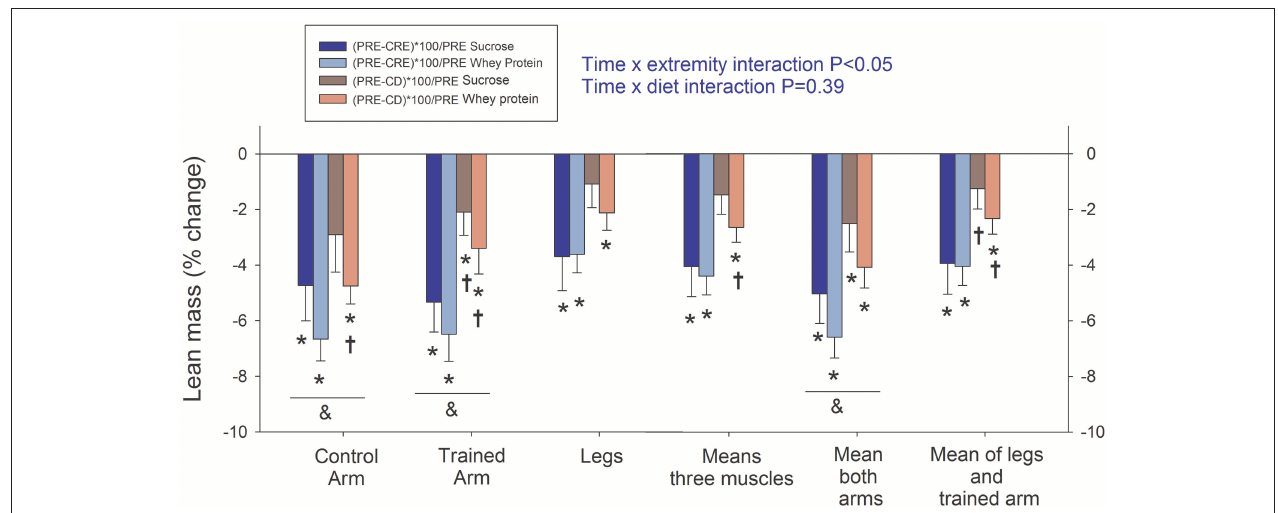
FIGURE 2 | Assessment of changes in lean mass (fat-free mass—bone mass) by dual-energy x-ray absorptiometry. PRE, baseline tests; CRE, caloric restriction (13.4 kJ/day) and exercise (45 min arm cranking and 8h walking per day) for 4 days; CD: 3 days on a diet isoenergetic with that consumed during the PRE phase + reduced exercise. The vertical bars represent the mean values and the error bars the standard error of the mean. Sucrose: in dark colors ( n = 7) and whey protein: in light colors ( n = 8). * P < 0.05 compared to PRE; † P < 0.05 compared to CRE; & P < 0.05 arms compared to legs.